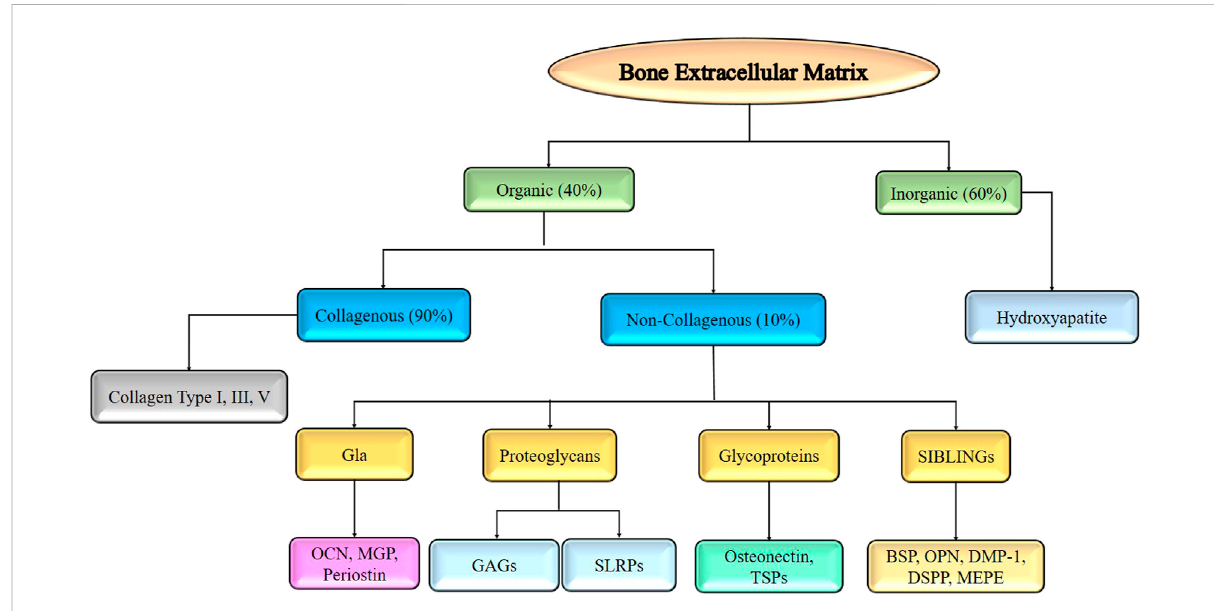
FIGURE 4 Components of bone extracellular matrix required for developing tissue engineered scaffold for bone